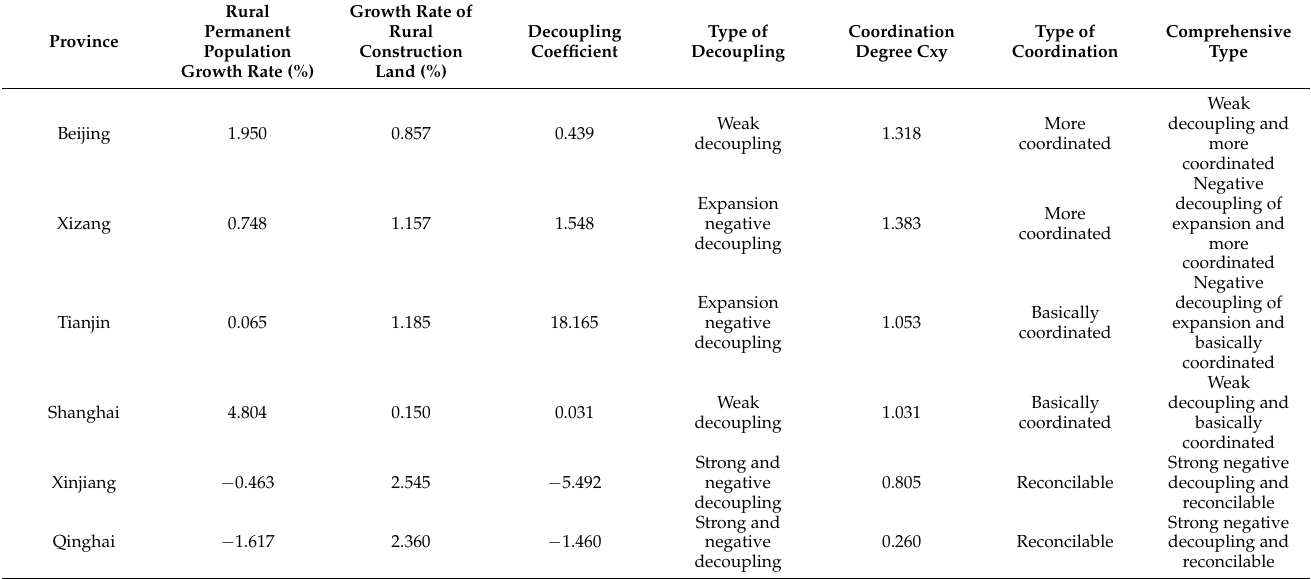
Table 3. The decoupling coefficient and coordination degree between rural construction lands and the rural permanent